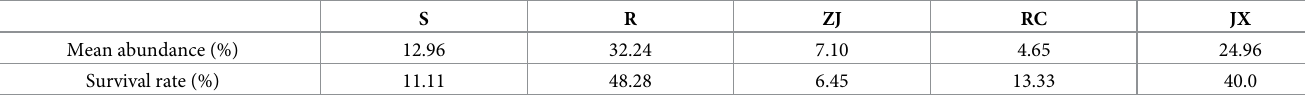
The CDC bottle knockdown experiment was carried out on five strains of mosquitoes. The survival rate refers to the proportion of female mosquitoes that can fly normally after 24h recovery. The mean abundance means the relative abundance of Serratia oryzae in intestinal symbiotic